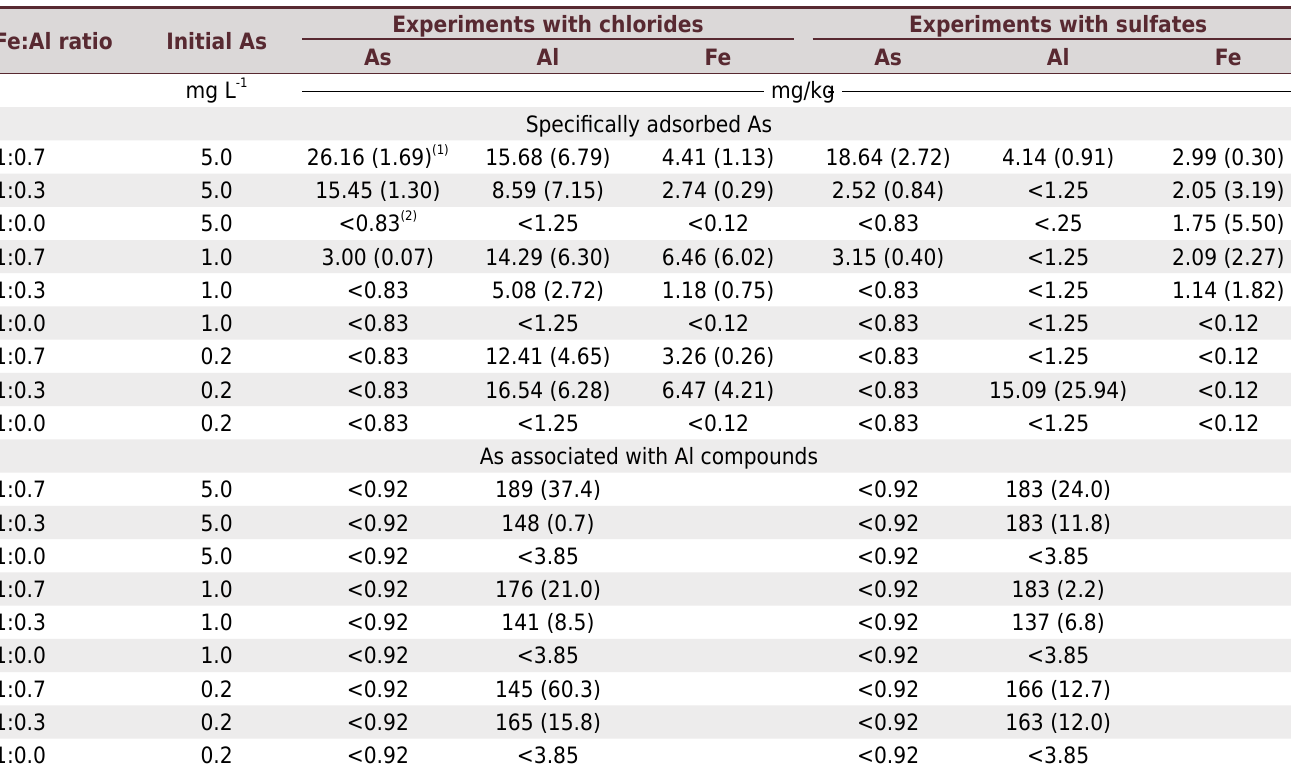
Table 9. Concentrations of As, Al, and Fe extracted from precipitates by potassium phosphate and ammonium fluoride, quantified by ICP-OES. Data calculated from values measured in the leachates and taking into account the precipitate/leachate ratio Experiments with chlorides Experiments with Fe:Al ratio Initial As